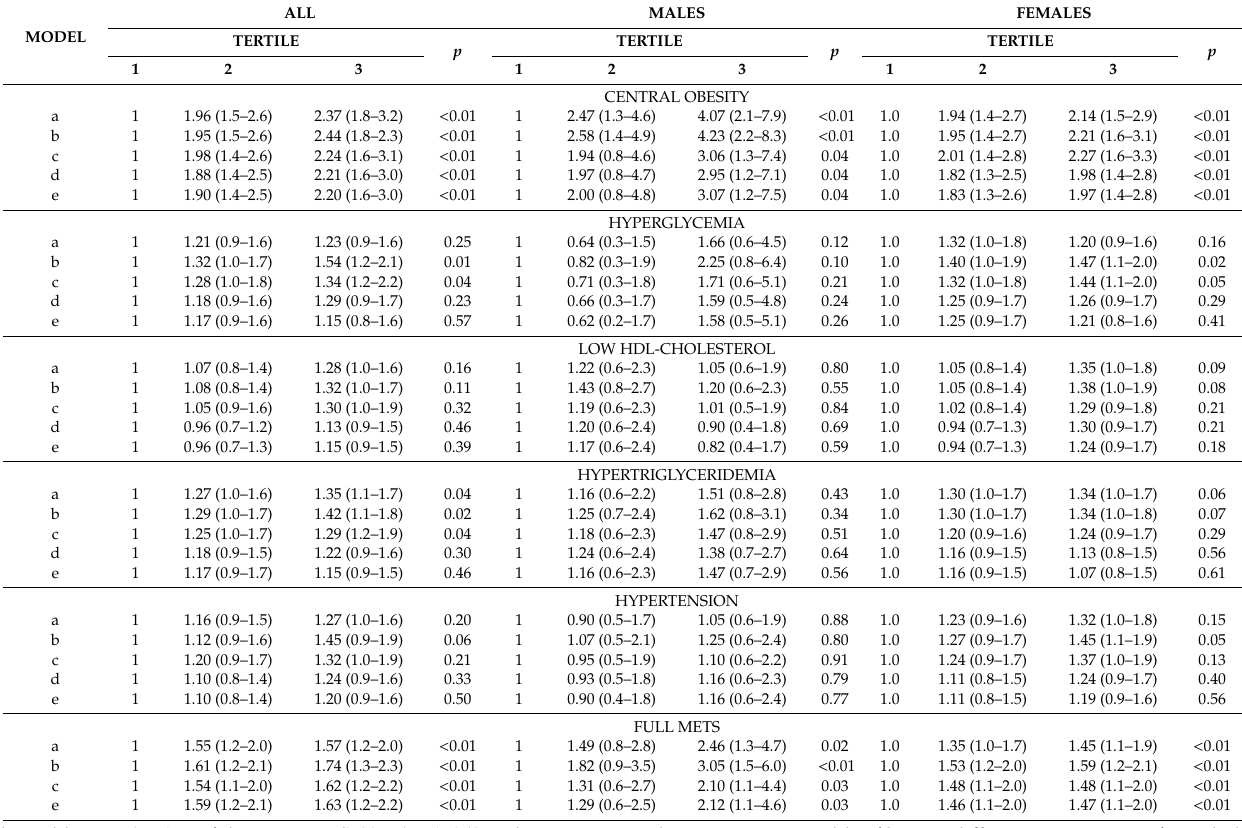
Table 3. Odds ratio of full metabolic syndrome and its components at di ff erent tertile of T-score (spine) according to sex.